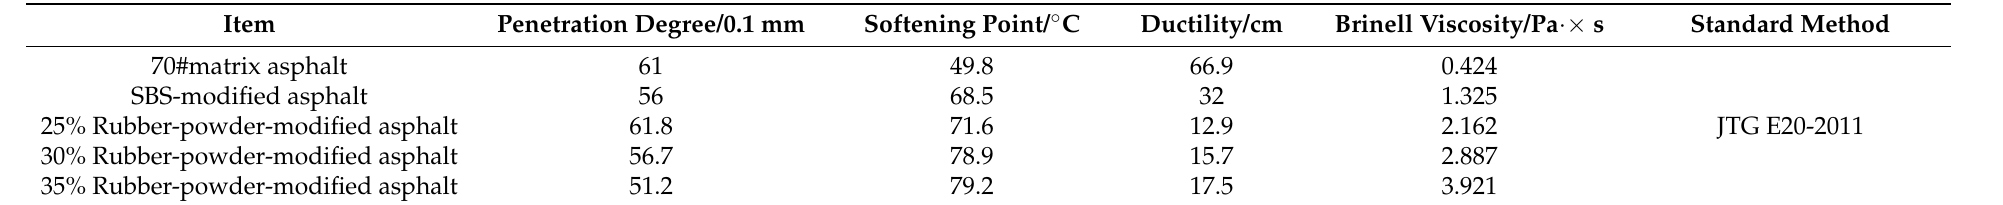
Table 1. Basic indications of